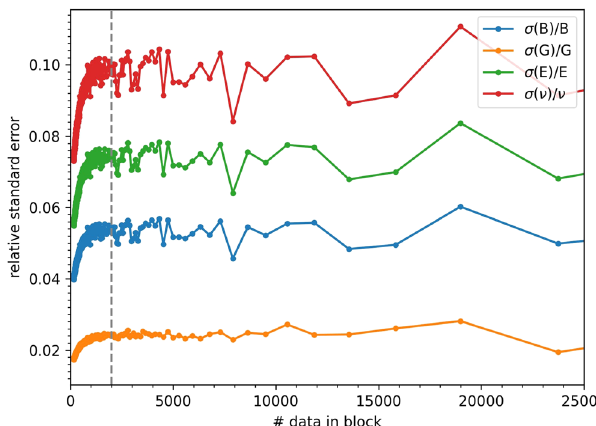
Fig. 3 Relative standard deviation (square root of the variance of the elastic modulus divided by the value of the mean) of B , G , E , and ν as a function of the number of data in block used to calculate the variance of V h i , ϵ h i and ϵϵ h i (see Section Results “ Elastic tensors and moduli from the strain fl uctuations" and Section Methods), from the 600 K- NPT CP molecular dynamics of t-LGPS. Here, the fi rst point on the right corresponds to four blocks, and the maximum number of blocks considered is 600. Based on this plot, we choose 47 blocks for the error block analysis of t-LGPS. Our choice is reported in the fi gure by the vertical dashed line (each block is ~4 ps long). Analogous plots for o-LGPS, t-LGPO, and o-LGPO are reported in Supplementary Figure 7.